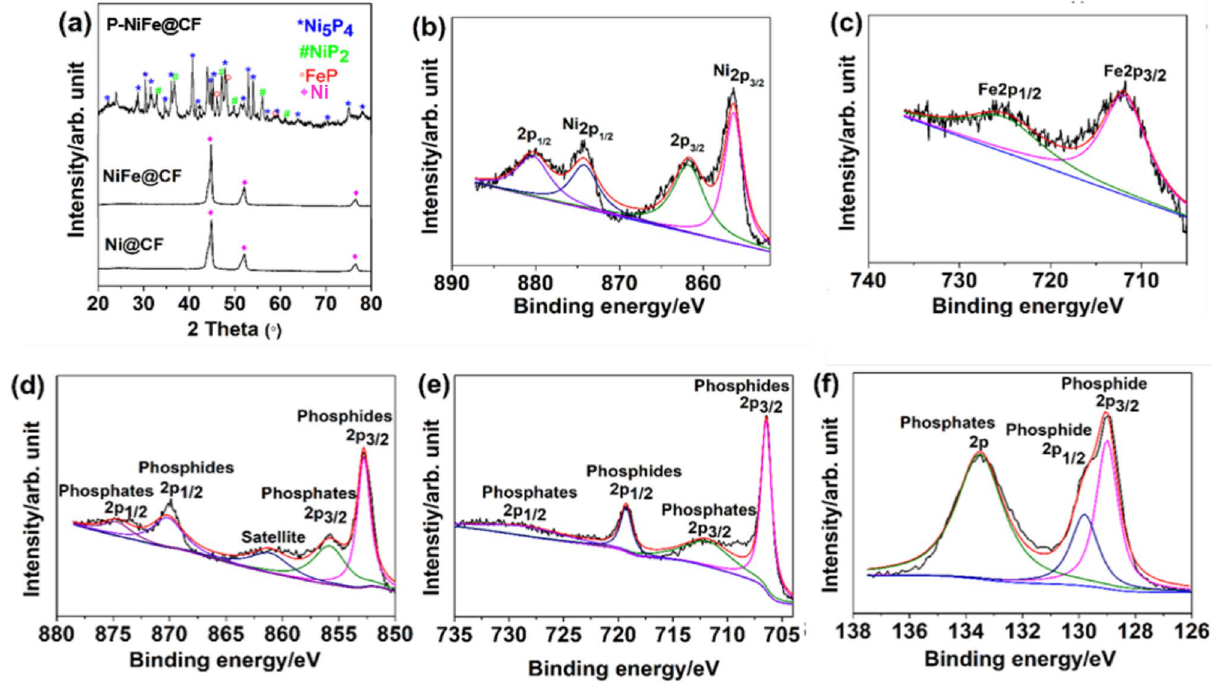
Figure 1. ( a ) XRD patterns of Ni@CF, Ni–Fe@CF, and P-NiFe@CF; and XPS binding energy plots for ( b ) Ni2p and ( c ) Fe2p peaks of Ni–Fe@CF, and Ni2p ( d ), Fe2p ( e ), and P2p ( f ) peaks of